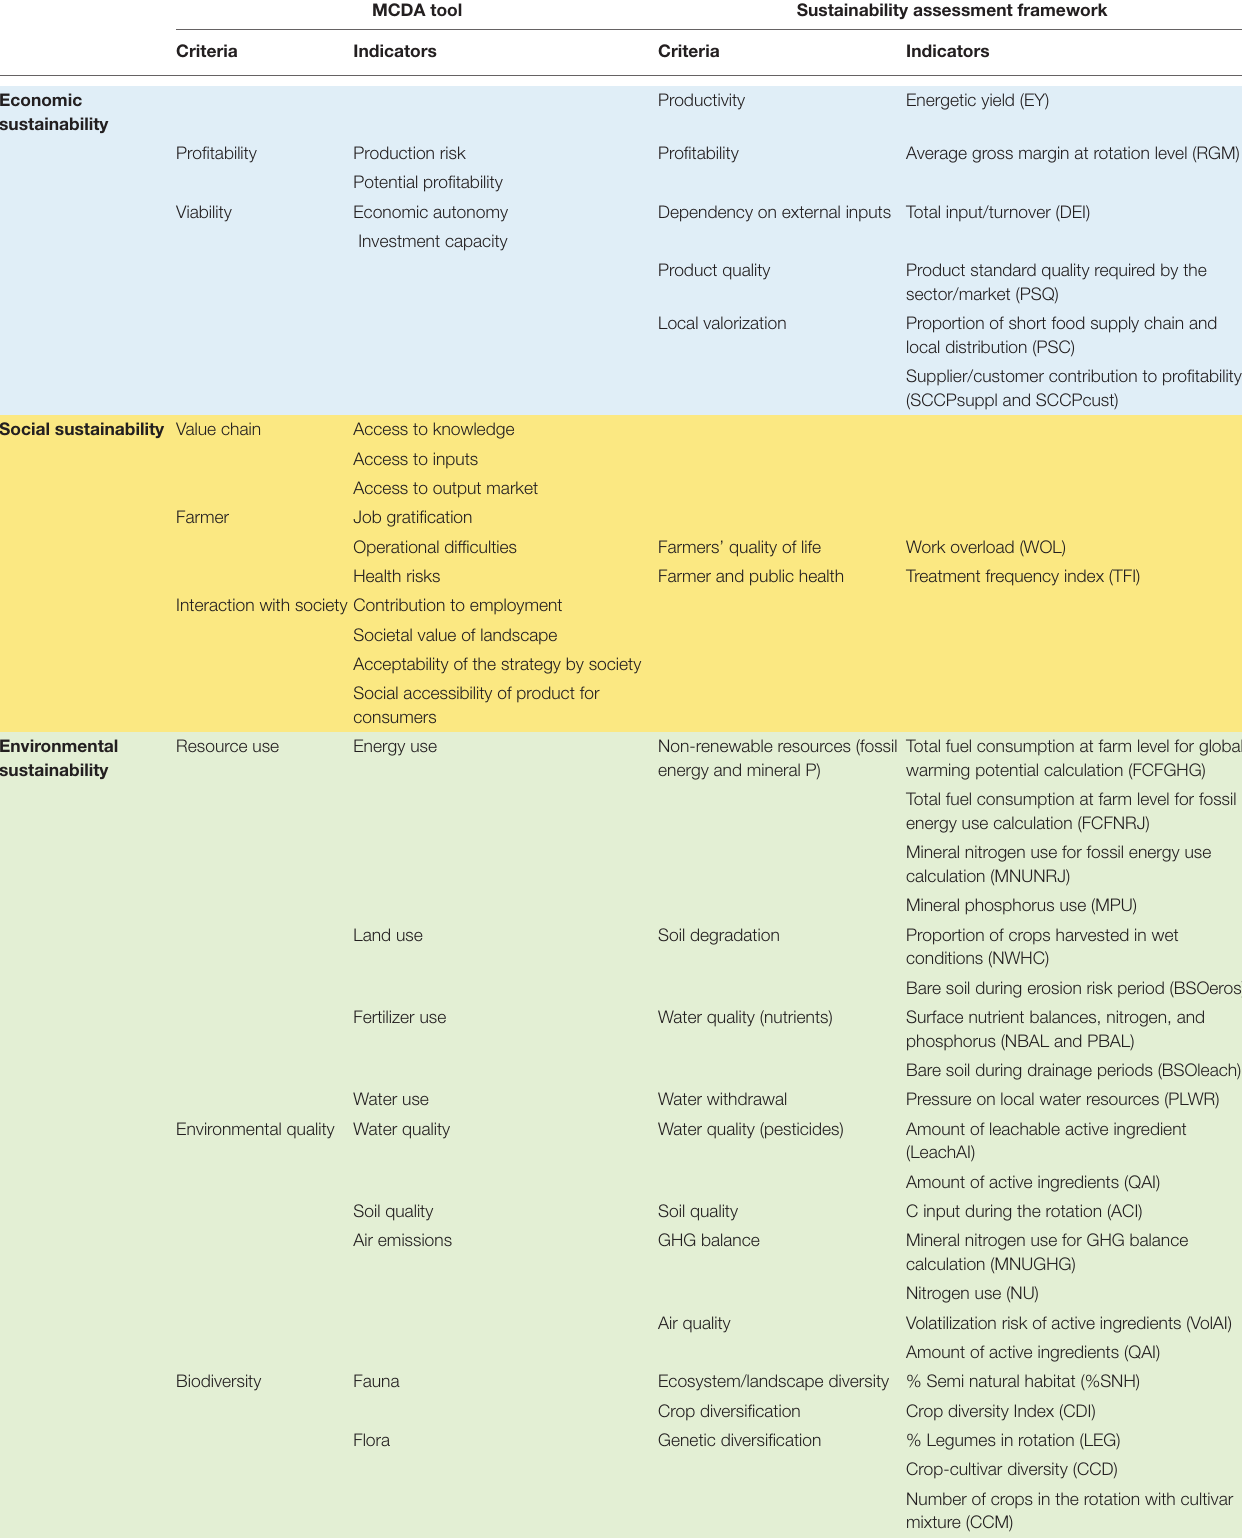
TABLE 2 | List of Indicators from the MCDA tool and SAF used to assess the sustainability of field experiments and commercial farms.